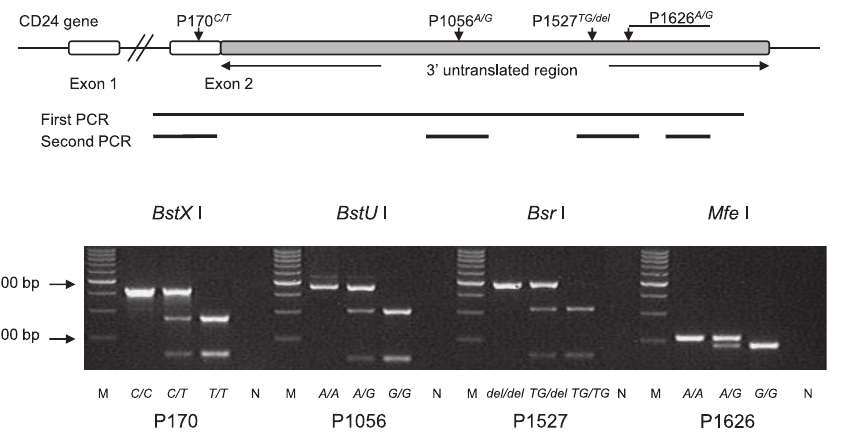
Figure 1. Diagram of the CD24 Gene and Genotyping of Four Polymorphic Sites by PCR-RFLP The upper panel shows the relative position of the 3 9 -UTR (gray box) and the two codon regions (white boxes). Intron 1 is represented as a separate line; however, the large intron 1 is not fully represented in the figure. The relative position of each polymorphism found in the study is shown by a downward arrow. The position of the nested-PCR primers is also shown. Lower panel shows genotyping by PCR-RFLP analysis using BstX I, BstU I, Bsr I, and Mfe I restriction enzymes for P170, P1056, P1527, and P1626, respectively. The genotype of each pattern is indicated at the bottom of each lane. M: molecular size marker (lane 1, 6, 11, and 16). Numbers on the left side are the size of a standard DNA marker (bp). N: negative control (lane 5, 10, 15, and 20).